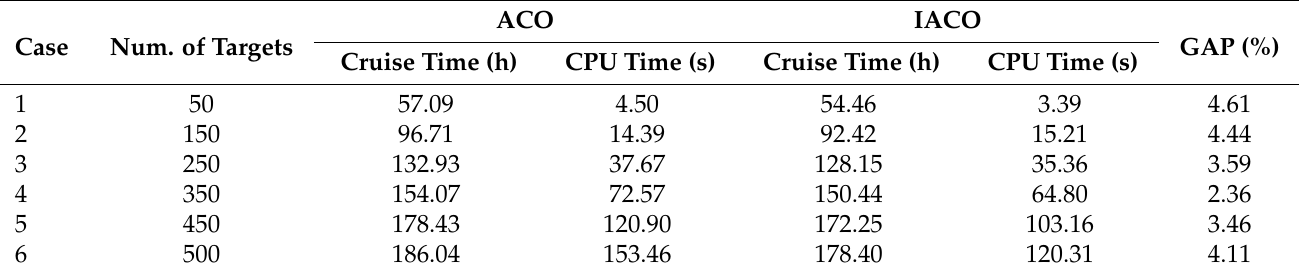
Table 4. Comparison results between ACO and IACO in 6 cases.